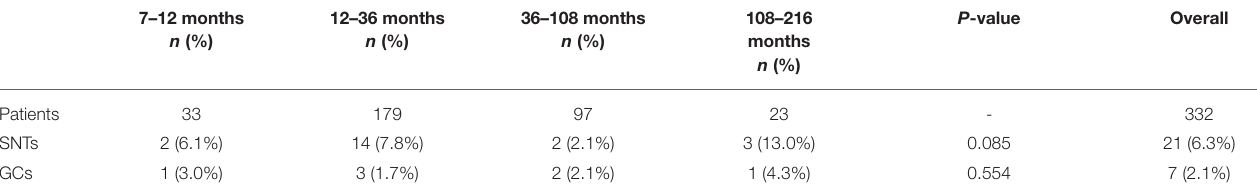
TABLE 2 | Summury of the four